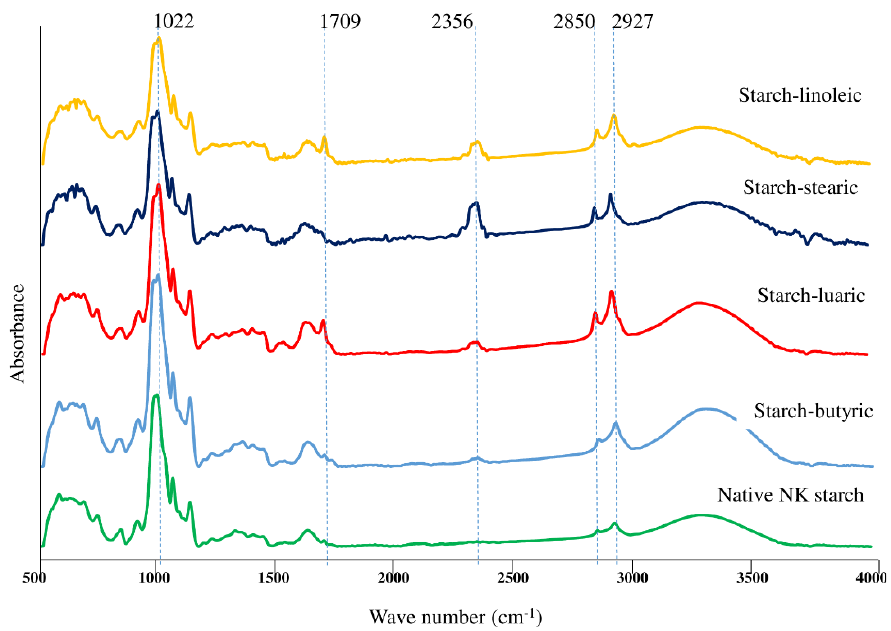
Figure 4. Fourier-Transform infrared (FTIR) spectra of native Noui Khuea (NK) starch and NK starch– lipid complexes with different fatty acid chain length.